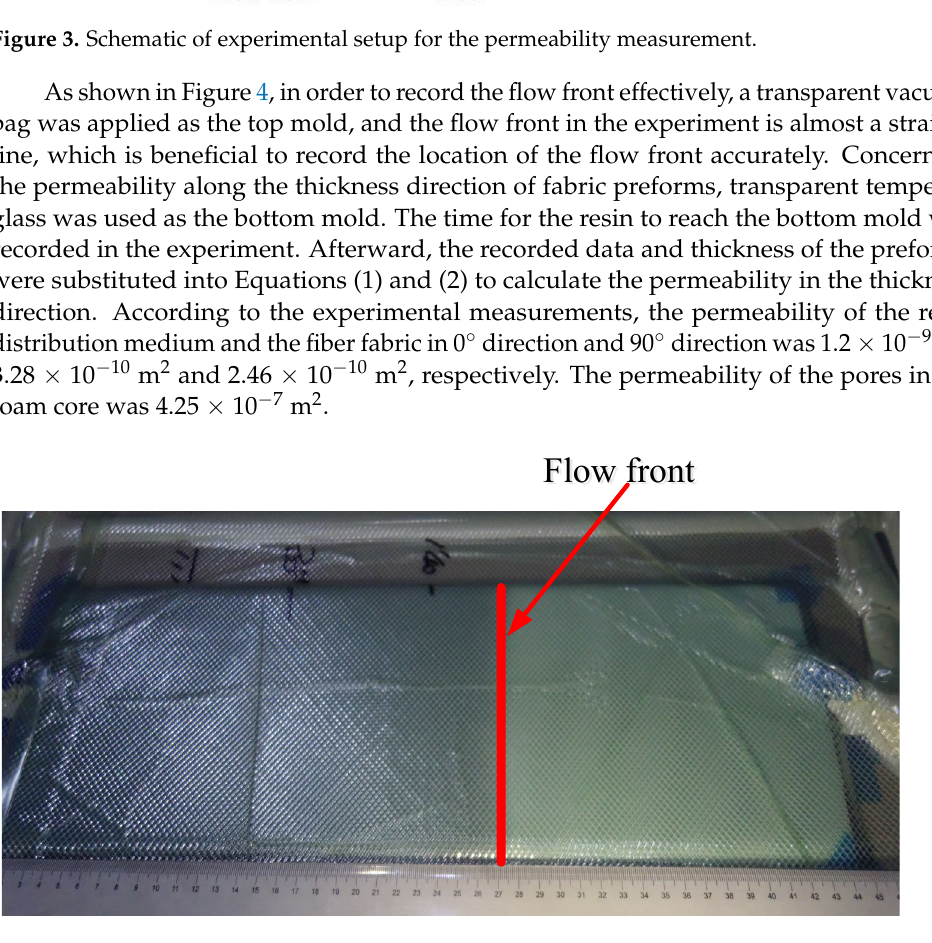
Figure 4. Resin flow front for the permeability